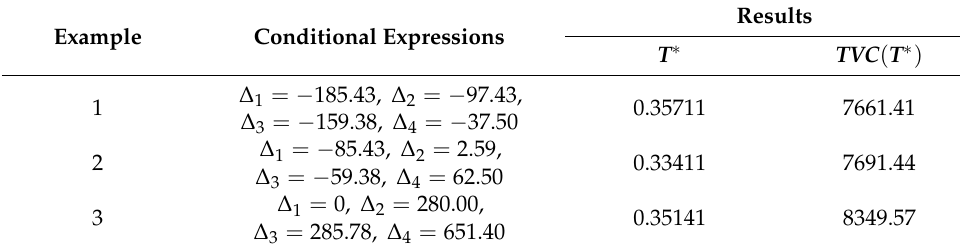
Table 3. The optimal results of T ∗ and TVC ∗ .